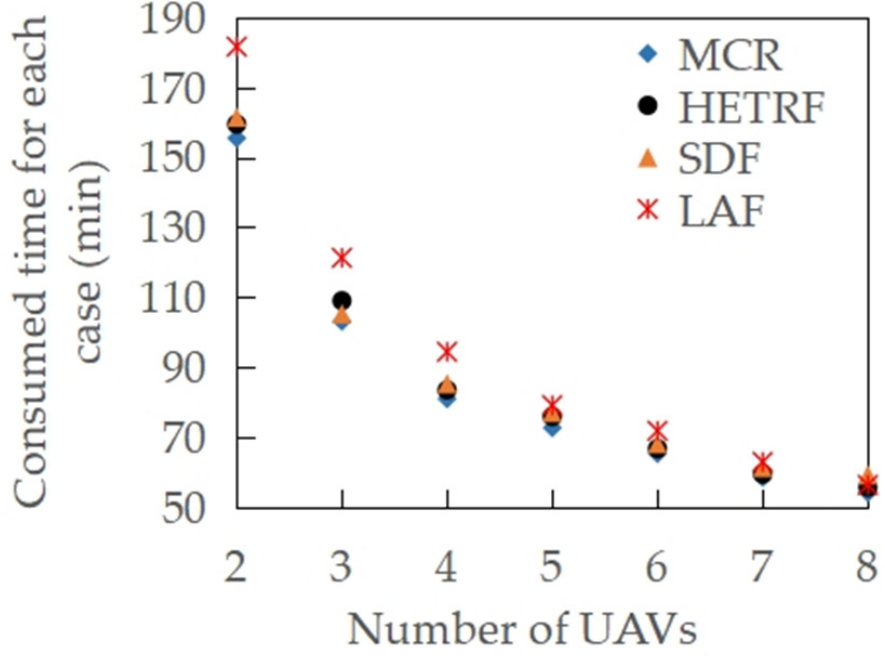
Figure 10. Time consumption changes with the number of drones.